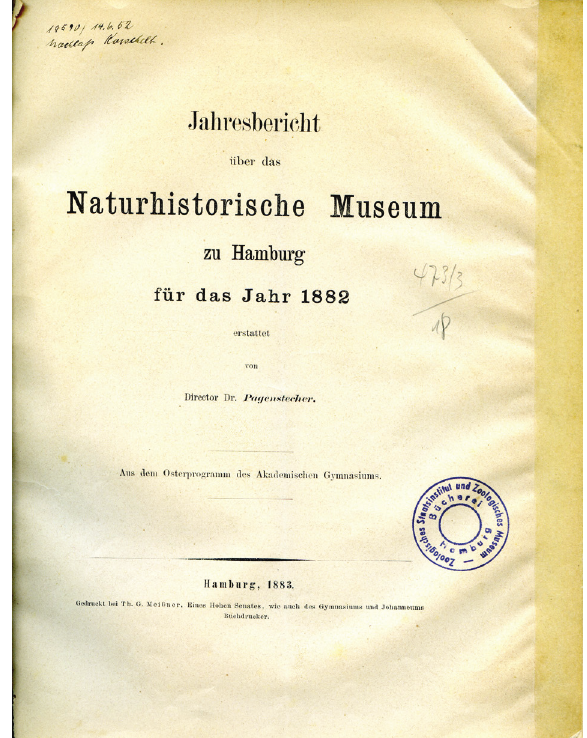
Figure 1. Title page of the “ Jahresbericht über das Naturhistorische Museum zu Hamburg für das Jahr 1882 ”, given as first annual report by the director Alexander Pagenstecher, published in 1883.